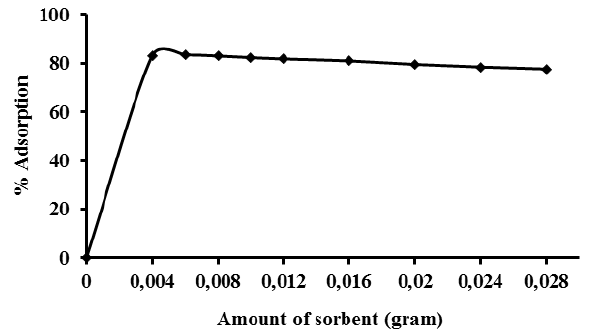
Figure 5: Effect of the Ni-Al-benzoate amount on the adsorption of amoxicillin.